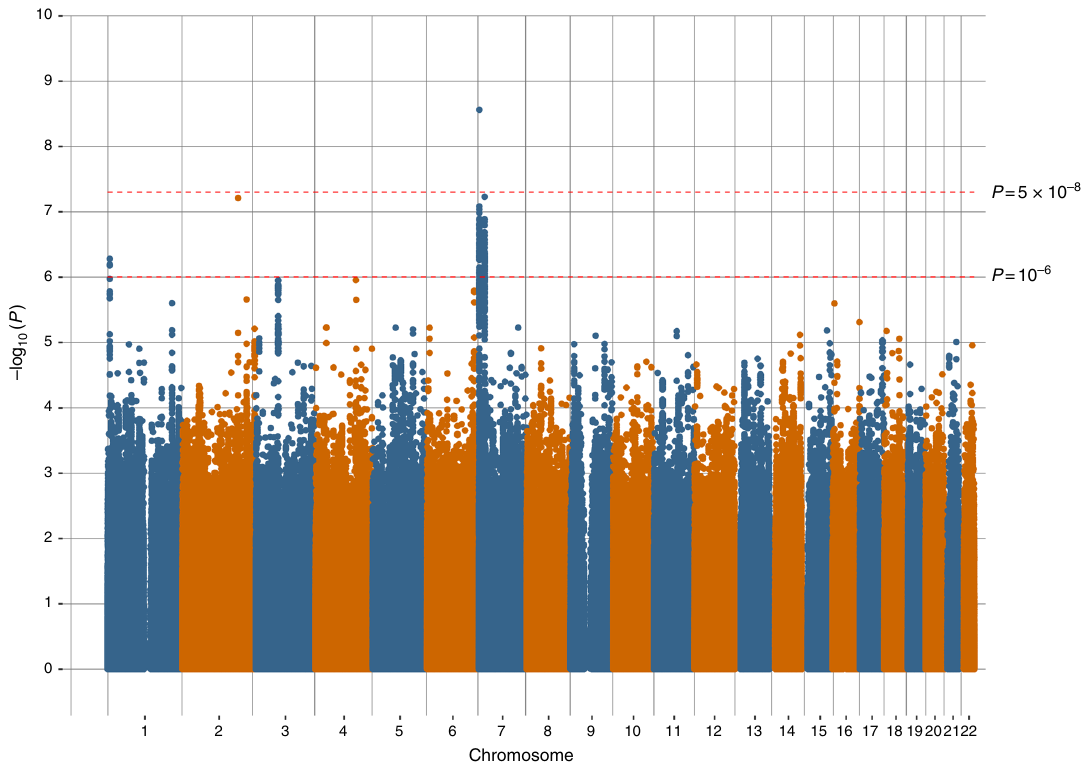
Fig. 3 Manhattan plot of the observed – log 10 P -values of each variant for an association with International Classi fi cation of Diseases-coded major depressive disorder ( n = 217,584) in the UK Biobank cohort. Variants are positioned according to the GRCh37